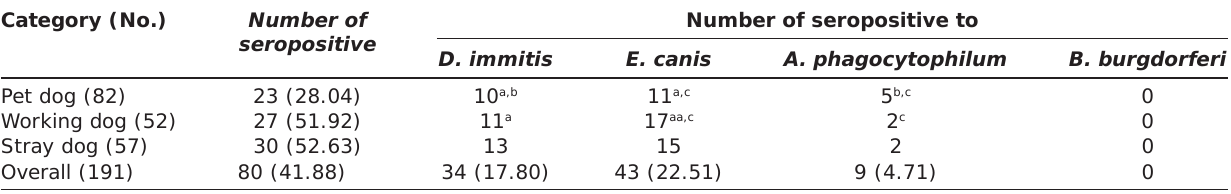
Table-1: Seroprevalence of D. immitis , E. canis , A. phagocytophilum and B. burgdorferi in dogs from North-East India. Category